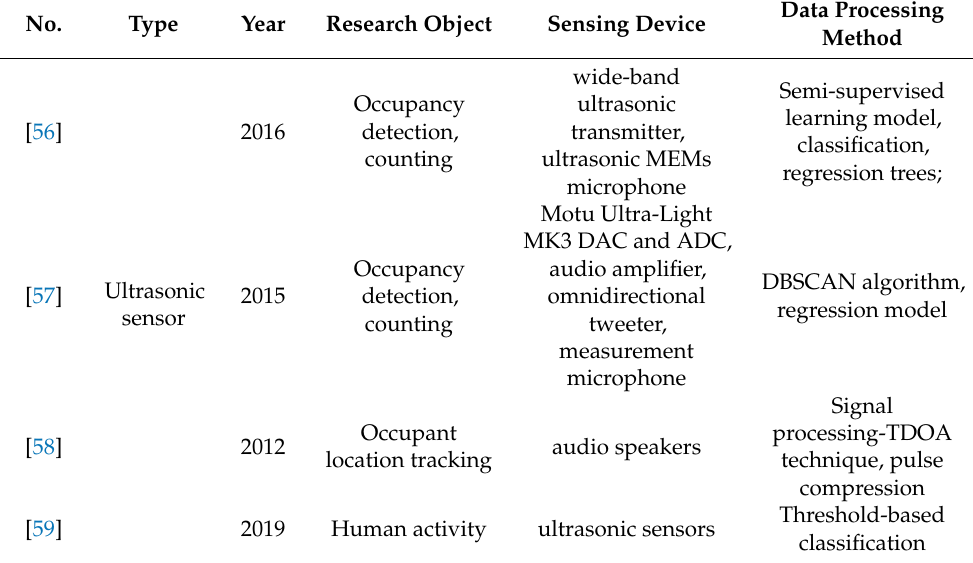
Table 4. The list of references for ultrasonic-based